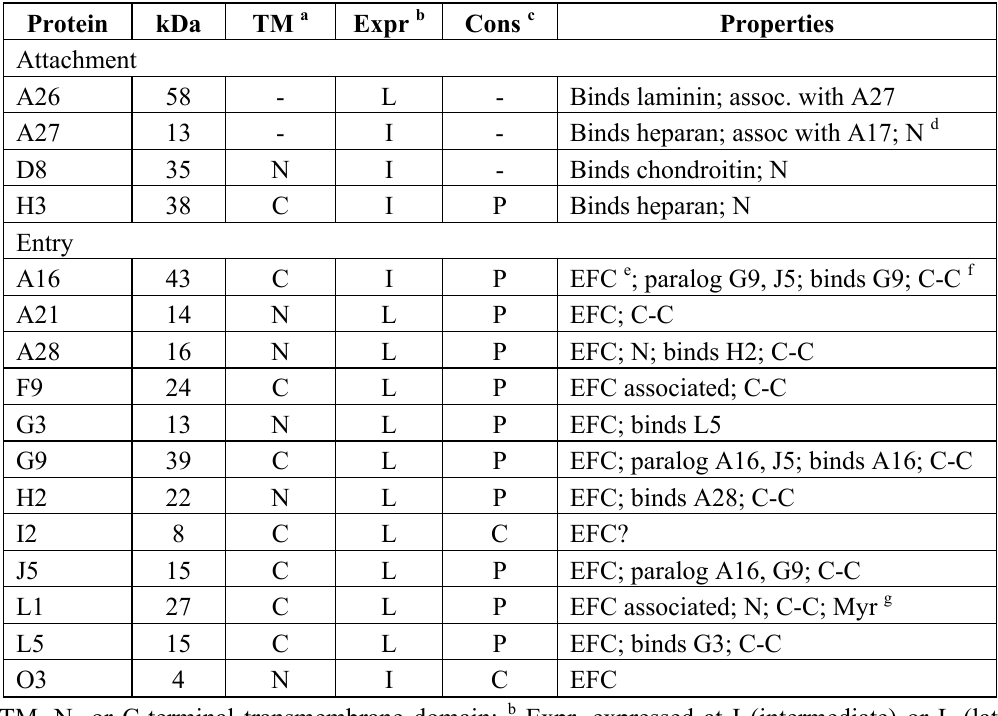
Table 1. VACV MV attachment and entry